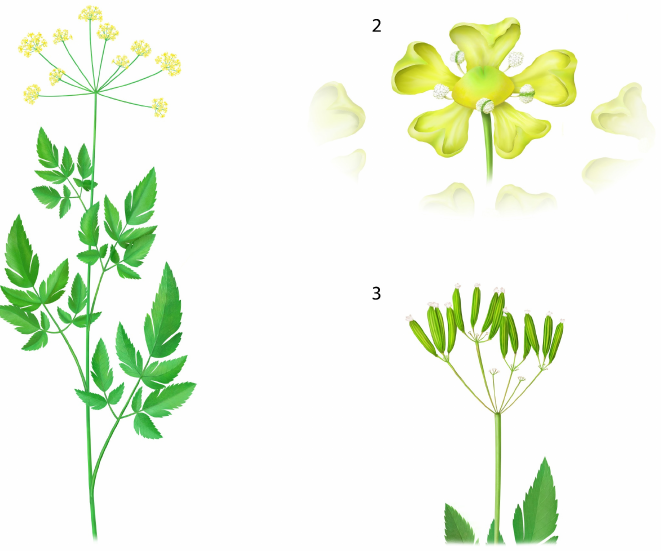
Figure 1. Botanical illustration of Osmorhiza occidentalis Torr. showing (1) above ground portions of the flowering plant, (2) close perspective of individual floret, and (3) plant bearing fruit. Illustrated by Rick Simonson, Science Lab Studios, Inc. (Kearney, NE, USA).